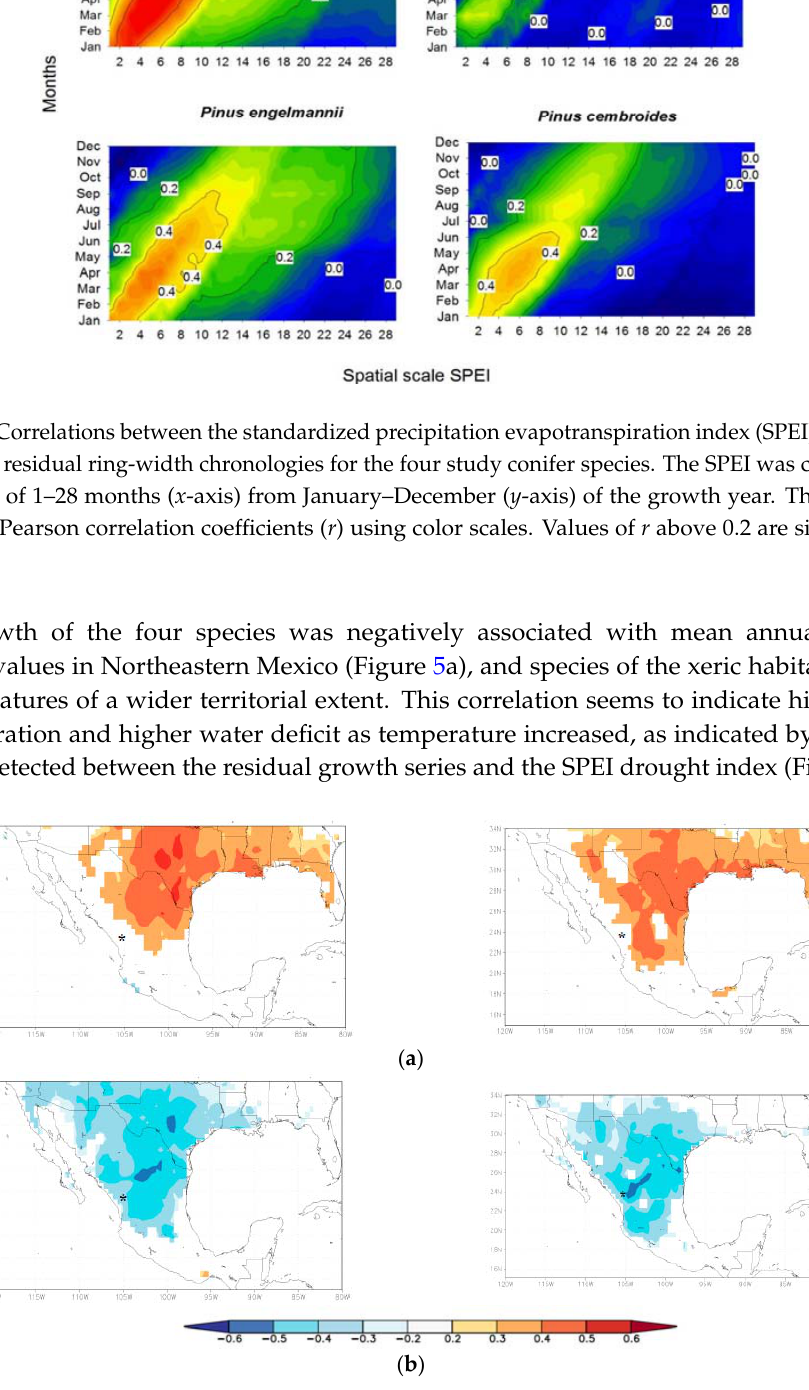
Figure 5. Spatial correlations calculated by relating residual ring ‐ width series of tree species from the mesic ( A. durangensis , C. lusitanica ; left plots), and xeric habitats ( P. cembroides , P. engelmannii right plots) with ( a ) mean maximum temperatures; and ( b ) the 6 ‐ month long SPEI drought index. The asterisk indicates the approximate situation of the study area. Field correlations have p < 0.10 in all cases.